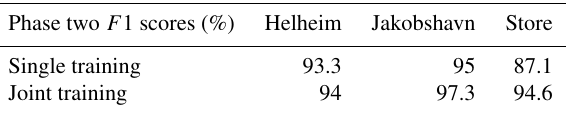
Figure 9. Examples of pixel-level classification outputs for season- ally variable imagery from the out-of-sample test site showing in- put images of Store in the first column, which were acquired on (a) 23 June 2020, (c) 14 September 2020, and (e) 8 October 2020 with the associated CSC outputs shown in (b) , (d) , and (f) . Clas- sifications produced using optimal parameters with F 1 scores and calving front error shown next to each classification. All Sentinel-2 imagery in this figure is courtesy of the European Union Copernicus programme. Table 2. Optimum F 1 scores for classifications produced with sin- gle and joint training (50 × 50 RGBNIR tiles). Note the joint ap- proach improves classification F 1 scores, with the biggest improve- ment for out-of-sample